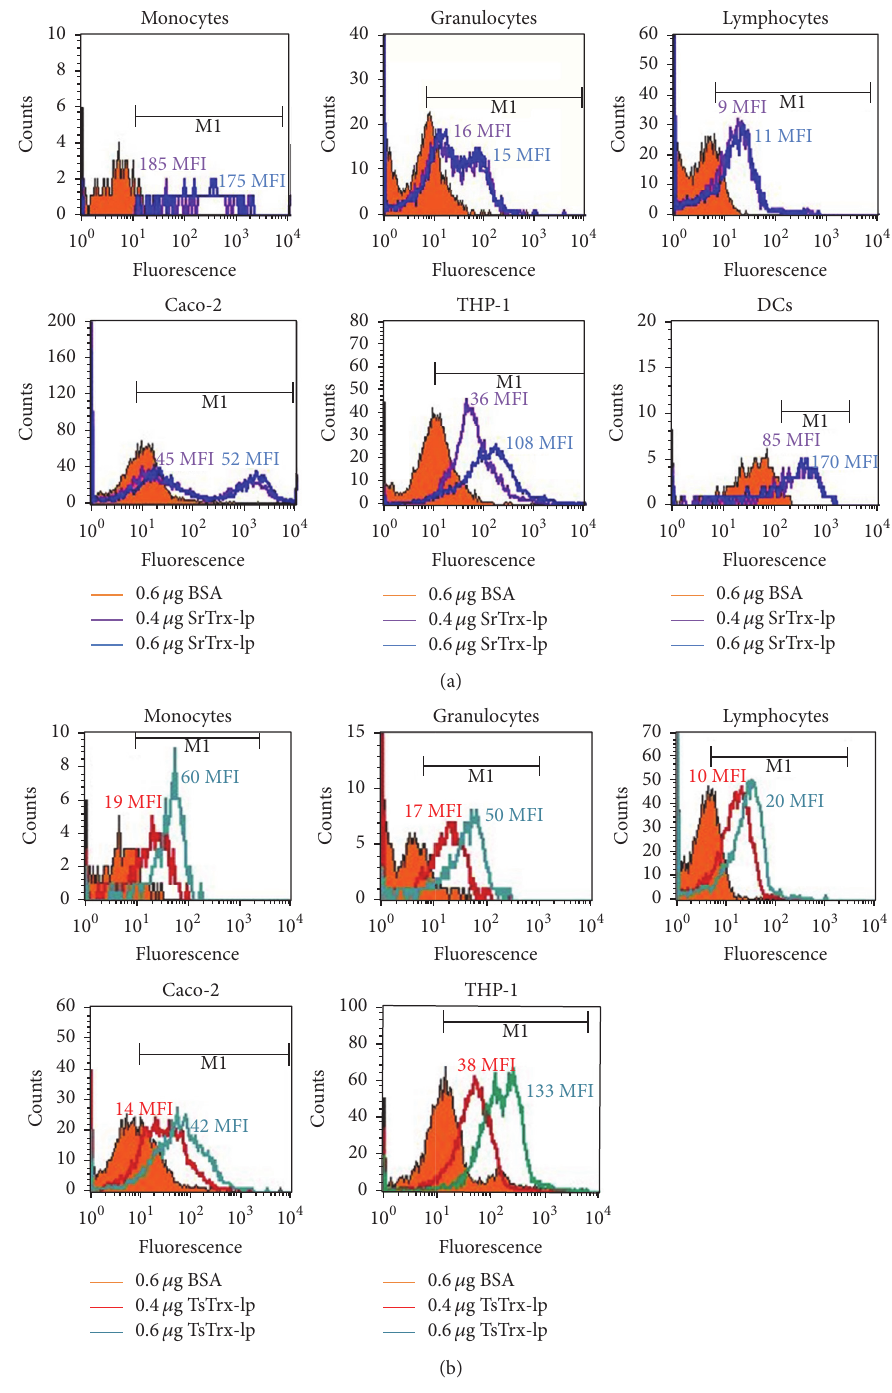
Figure 5: Binding of the SrTrx-lp (a) and TsTrx-lp (b) to different cell types. 2 × 10 5 cells were incubated at 37 ∘ C for 30 min with Alexa Flour (cid:2) - labeled SrTrx-lp or TsTrx-lp. Here, peripheral blood cells (monocytes, granulocytes, and lymphocytes) as well as cell culture cells (Caco-2 cells, THP-1 cells, and THP-1-derived DCs) were tested with 0.4 𝜇 g (purple (a), red (b) line) and 0.6 𝜇 g (blue (a), green (b) line) of labeled protein determining the median fluorescent intensity (MFI). The intensity of surface fluorescence (FI, 𝑥 -axis) is plotted against cell counts. (The counts in the figures represent the median fluorescence index values.) Representative results of five independent experiments are